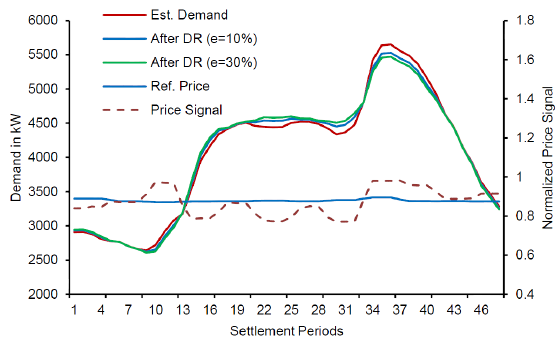
Figure 10. Aggregate demand response curves for aggregated elasticities of 10% and 30% respectively. The reference price and the actual price signals are normalized between 0 and 1.